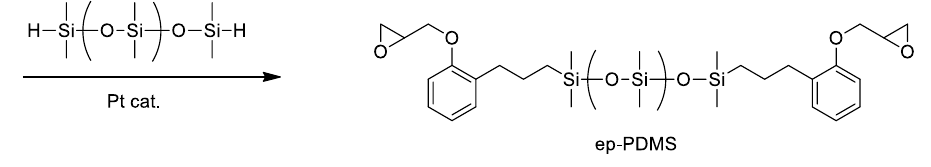
Figure 1. Synthesis of ep-PDMS.